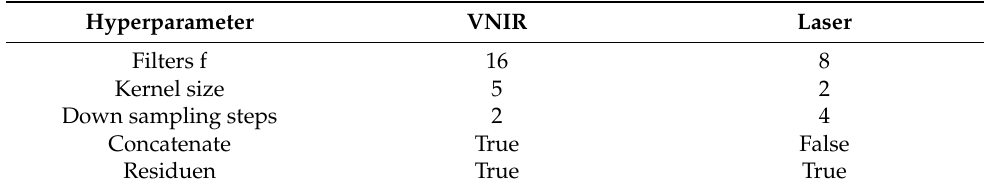
Table A1. Best found hyperparameters (see Section 2.2.5) for the U-Nets trained on the four data sets VNIR HSI (VNIR) and Laser HSI